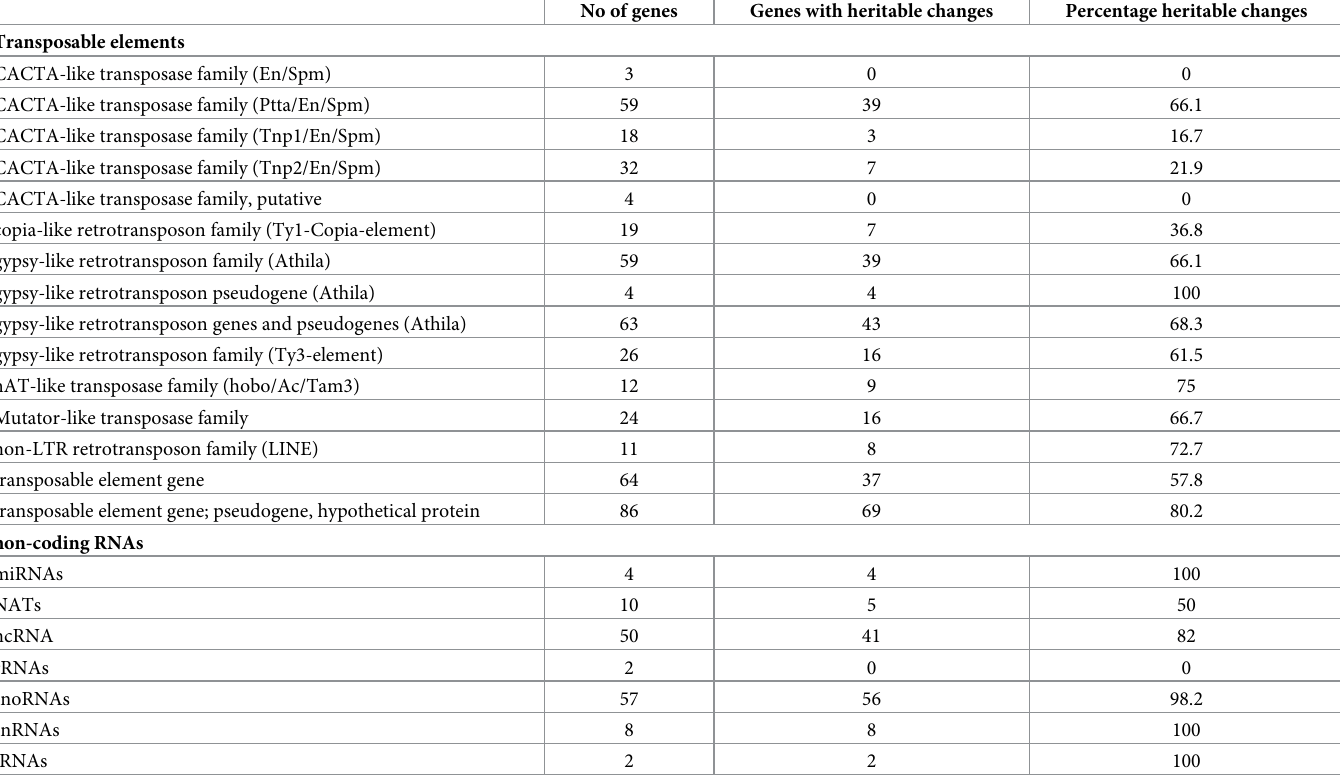
Table 1. Summary of transposable elements and genes expressing non-coding RNAs with altered transcript levels and their heritability rates. Data were compiled for different categories of transposable elements (S5 Table) and genes expressing non-coding RNAs (S6 Table) that showed at least log2-fold changes of +/- 2.5 in line A1 + compared to wildtype. For each gene the values in A1+ and A1- were compared to score the heritability of expression